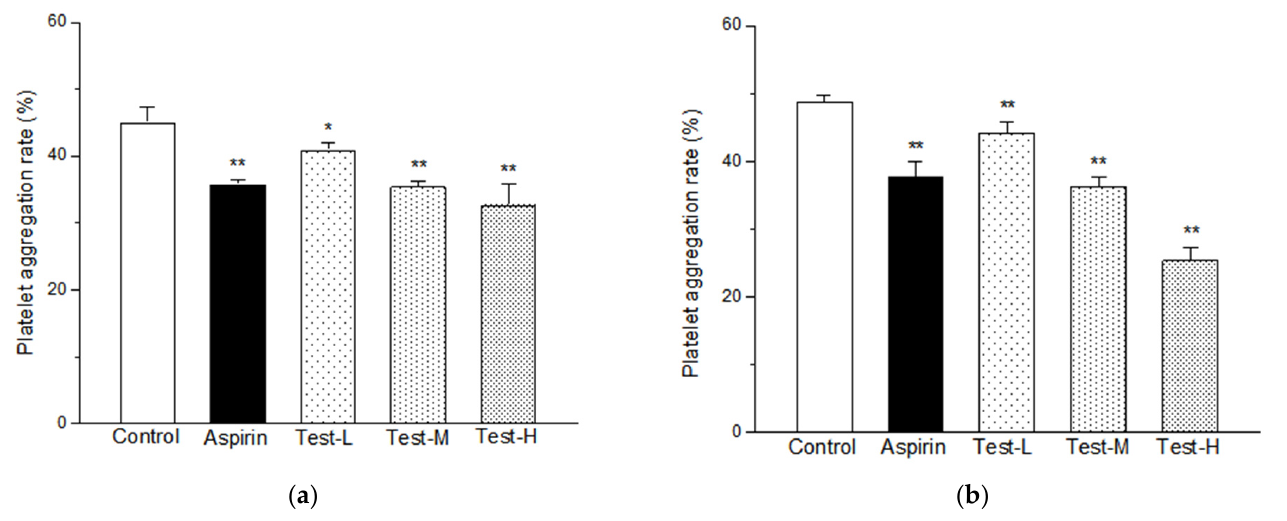
Figure 5. The effects of AAP-b2 on ADP- ( a ) and collagen-induced ( b ) platelet aggregation in vitro. * p < 0.05 and ** p < 0.01 compared to the ADP or collagen control